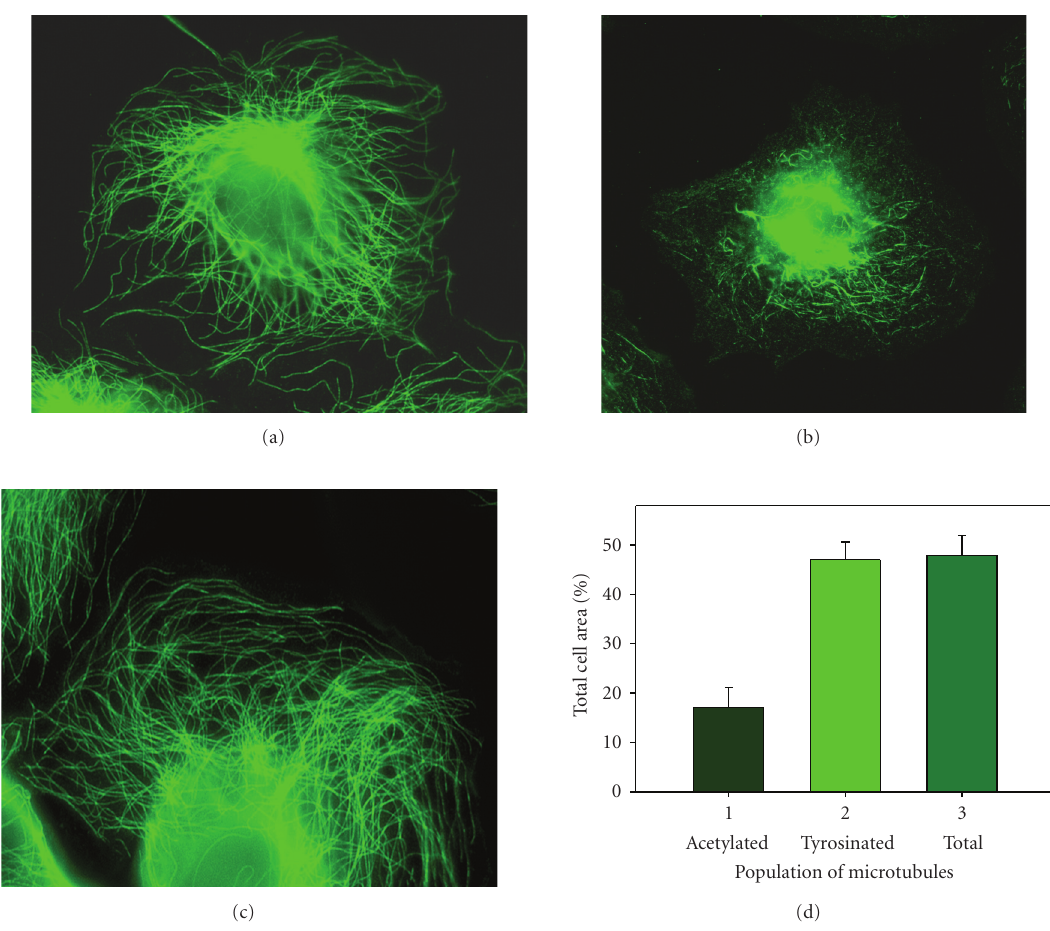
Figure 1: Dynamic microtubules are directed towards and their ends reach the cell periphery. HPAEC were fixed and processed for immunofluorescence microscopy. (a) Antibodies against β -tubulin were used to detect total microtubule population of the cell; (b) antibodies against acetylated tubulin were used to detect stable microtubules; (c) antibodies against tyrosinated tubulin were used to detect dynamic microtubules. Scale bar, 20 μ m; (d) relative area occupied by microtubules (% of the total cell area): 1 —acetylated microtubules; 2 —tyrosinated microtubules; 3 —total population of cell microtubules.